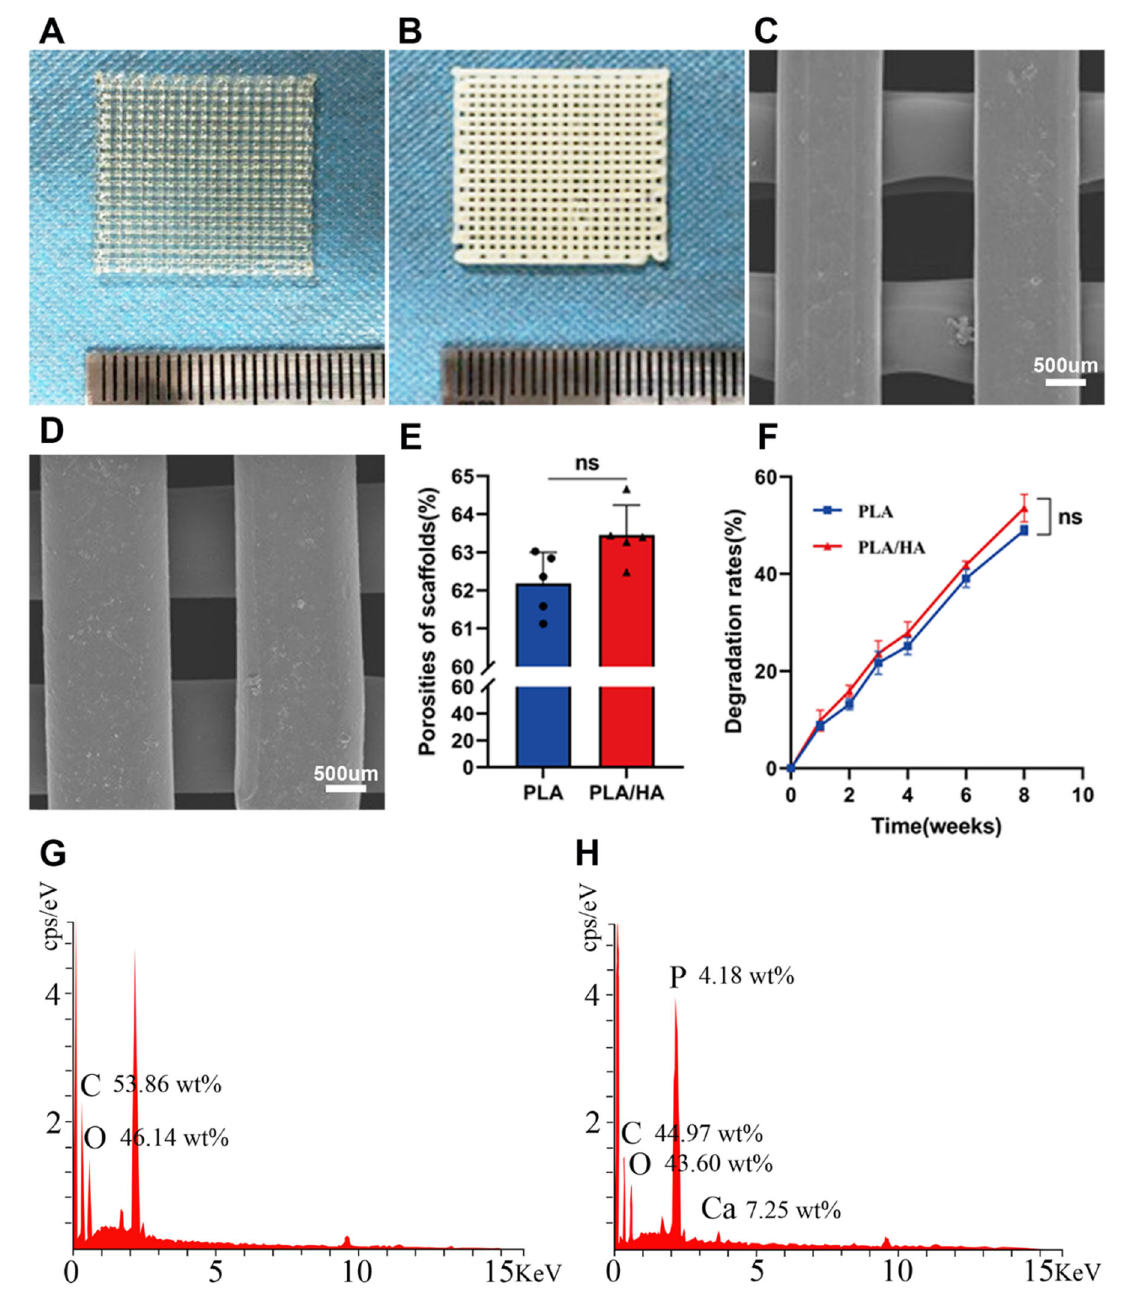
( F ) of the PLA and PLA/HA scaffolds. G , H Electron dispersive X-ray